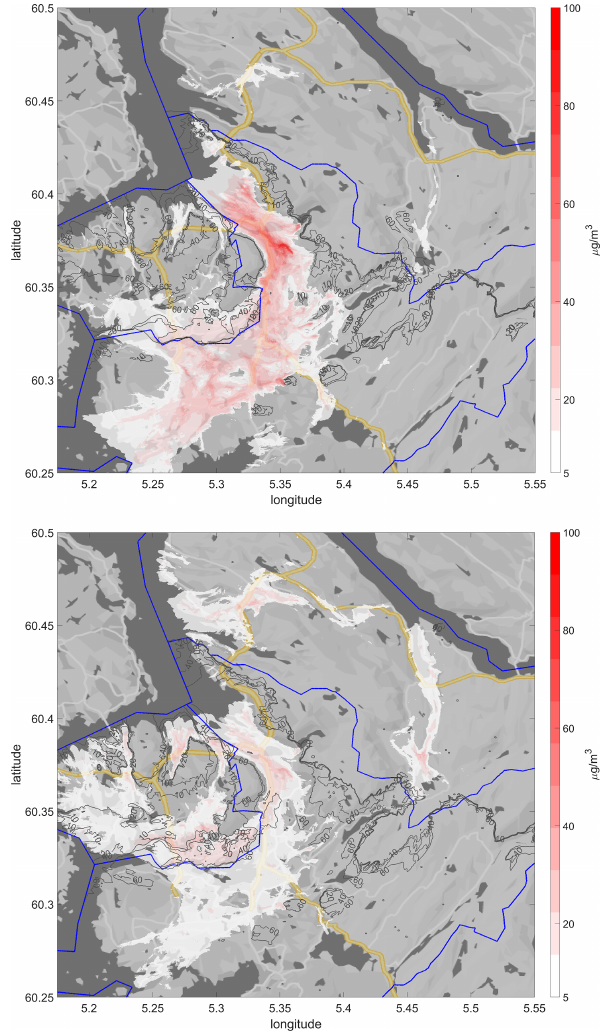
Figure 6. The same as in Fig. 4 but for the emissions expected when all older stoves have been replaced with the new stoves in Bergen- hus, Årstad, Fana and Ytrebygda districts (top) or in Laksevåg, Fyllingsdalen, Åsane and Arna districts (bottom). The boundaries of the districts are highlighted with the blue lines. Thin grey isolines indicate the fraction of the total pollution that was caused by the respective districts, when compared to the total pollution distribu- tion in Fig. 3 (top). Data overlay the grayscale map from © Google Maps